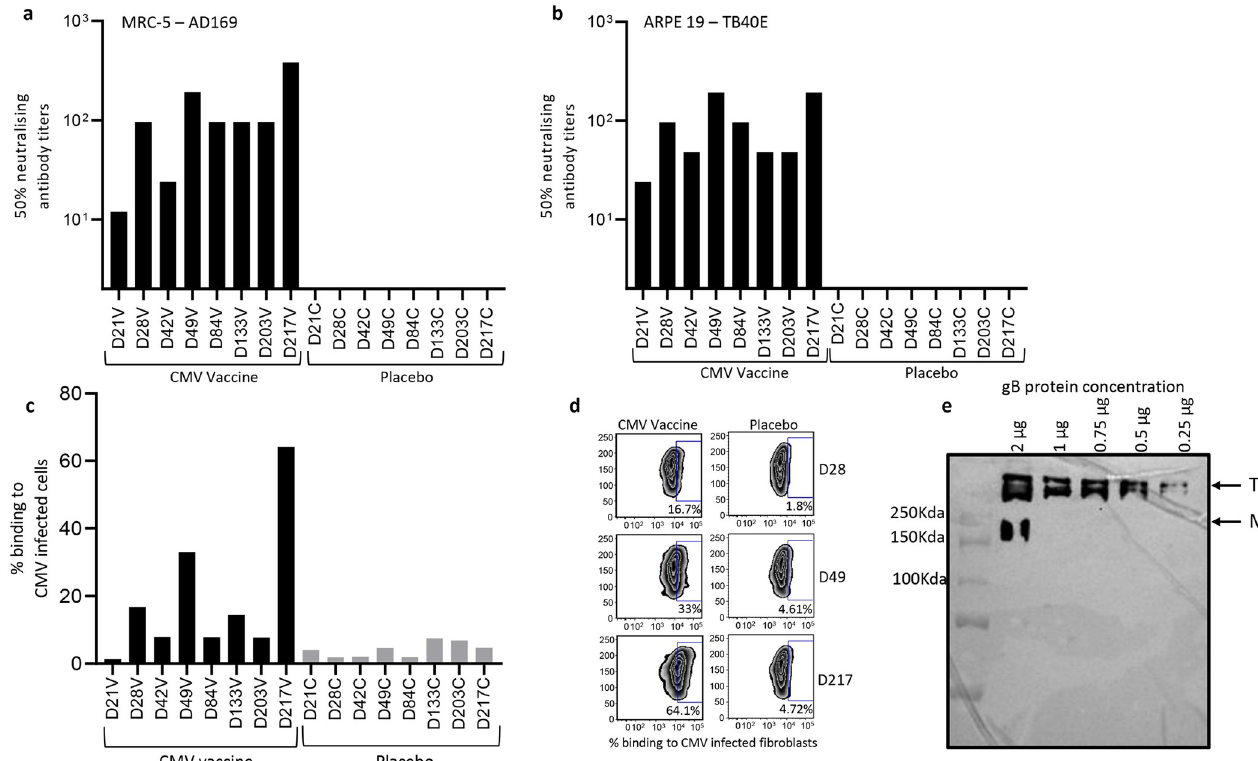
Fig 10. Functional characterisation of CMV vaccine formulation induced antibody responses : HLA A24 expressing mice were immunized with CMV vaccine as outlined in Fig 6A. Serum samples were collected at each time point and assessed for CMV neutralising antibody responses using microneutralisation assay. Neutralising antibody responses were measured by IE-1 staining in fibroblasts infected with CMV AD 169 and in ARPE 19 cells infected with CMV TB40/E strain. (a and b) Neutralising antibody titres induced following immunisation with CMV vaccine or placebo on day 21, 28, 42, 49, 84, 133, 203 and 217 against CMV AD 169 and TB40/E strains. (c and d) Flow cytometry analysis of binding of gB-specific antibodies to fibroblasts infected with CMV AD169 strain. (e) Western blot analysis of antibodies induced following immunisation with CMV vaccine or placebo binding to CMV gB monomer (M) or trimer